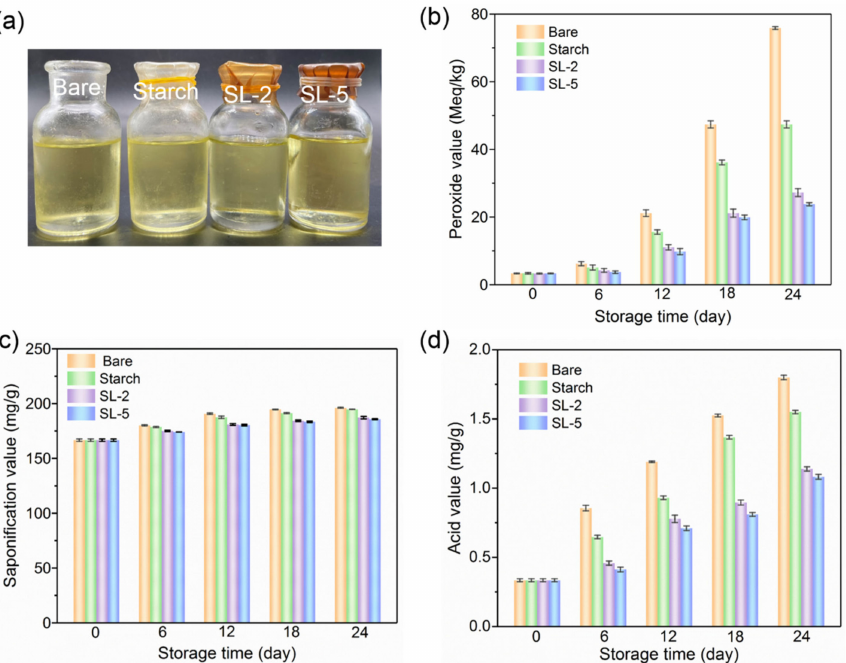
Figure 9. ( a ) Image of experiment for soybean oil accelerated oxidation, changes of ( b ) the peroxide value, ( c ) saponification value, ( d ) acid value of peanut oil packaged by starch film, SL-2 and SL-5 composite